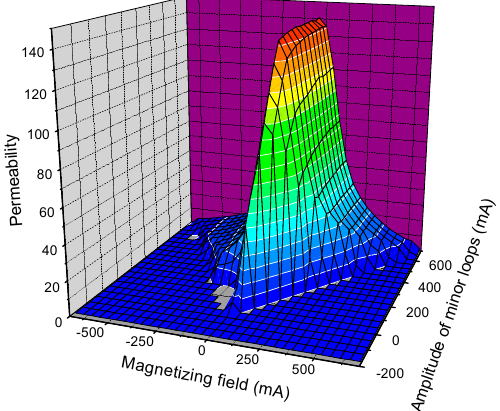
Figure 4. Permeability matrix of the as received 15Kh2NMFA sample.